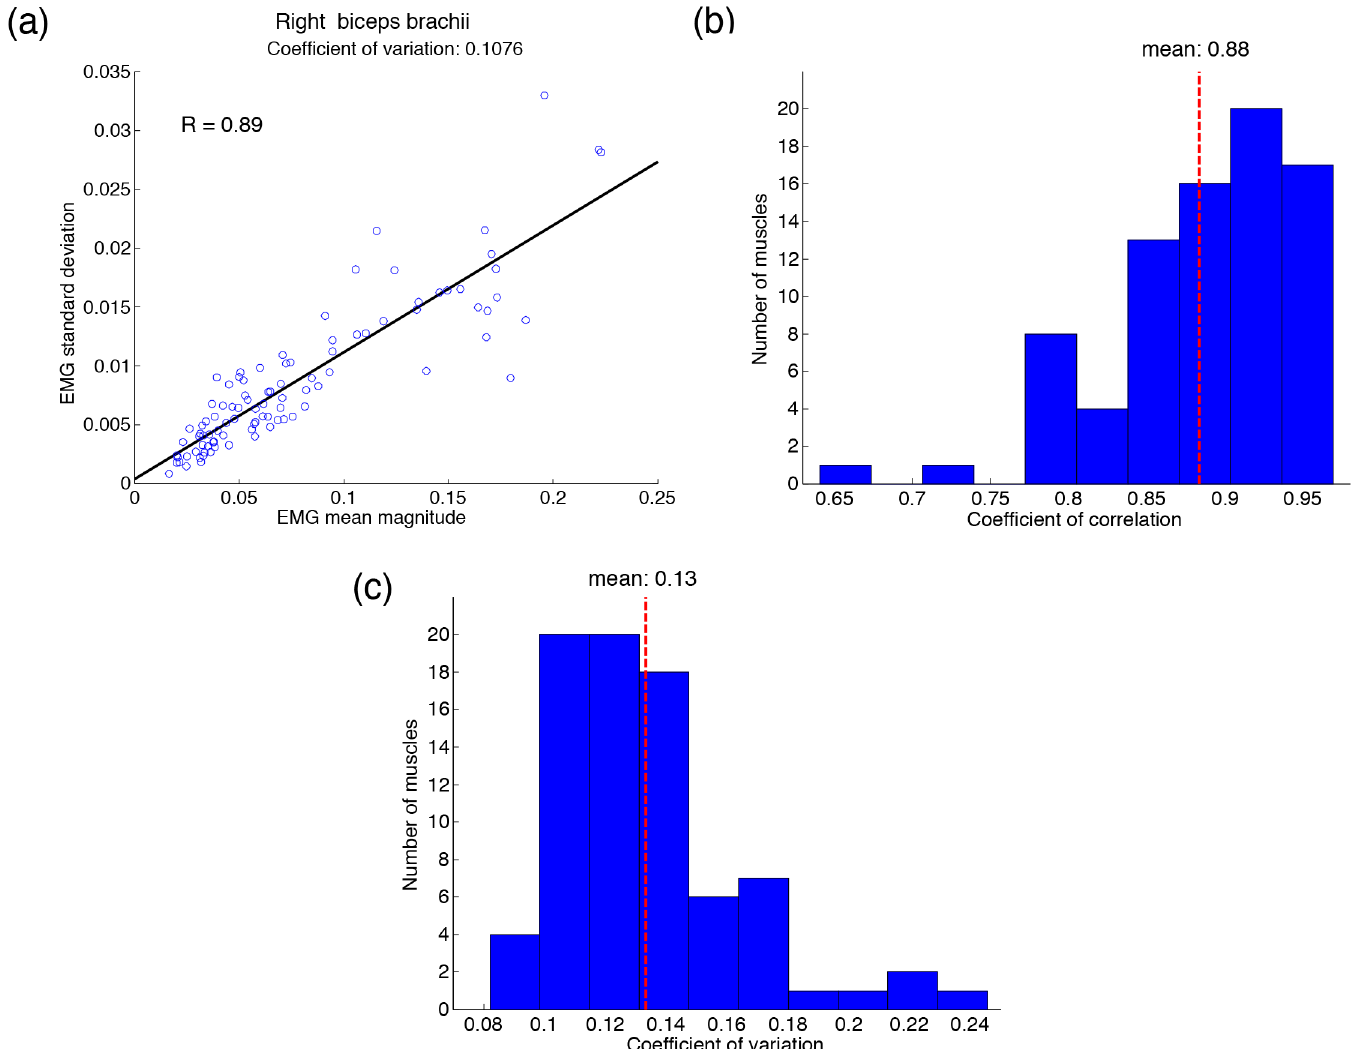
Fig 6. Determined coefficient of variation of each muscle. (a) A relationship between the mean magnitude and standard deviation of the EMG of one muscle of a typical subject. The slope indicates the coefficient of variation. The histogram of coefficient of correlation (b) and coefficient of variation (c) of all muscles of all subjects. The red dashed-line denotes the mean